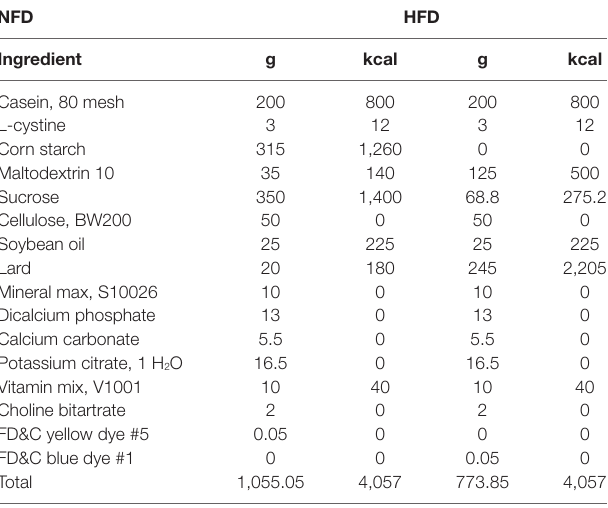
Table 1 | Compositions of NFD and